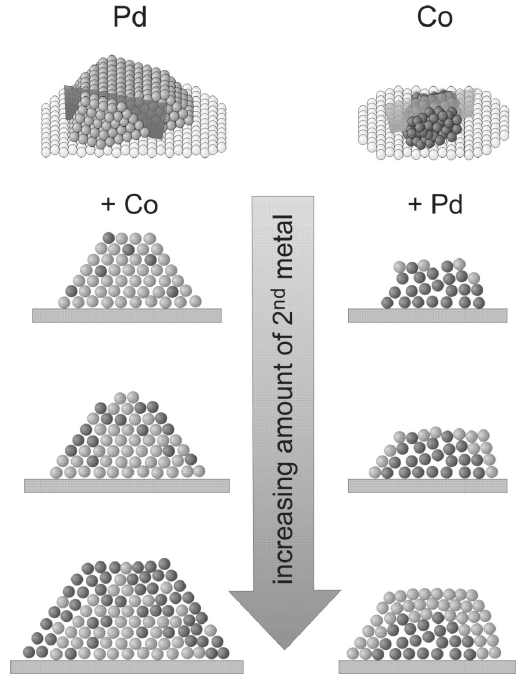
Fig. 18 – Schematic representation of the growth mode as inferred from IRAS, TPD, XPS, and STM data (Carlsson et al.